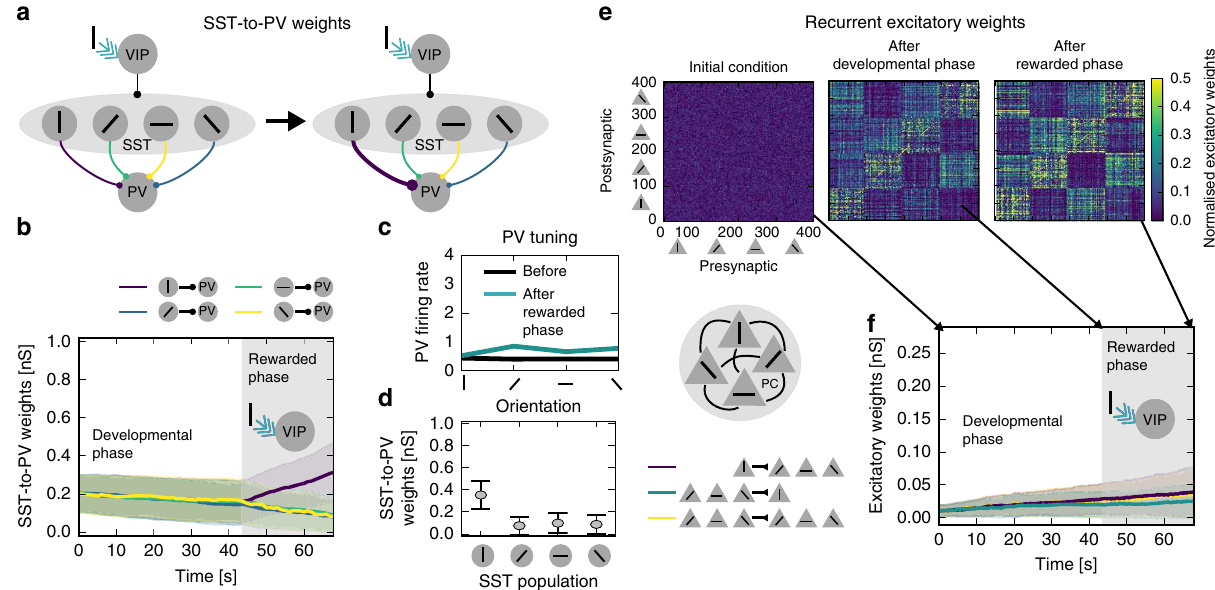
Fig. 2 Top-down reward signal triggers plasticity in the inhibitory circuit. a Illustration of changes in the inhibitory structure during top-down modulation (cyan arrow). b Evolution of the inhibitory SST-to-PV connections, grouped according to SST tuning preference (colours match the connections in a , shown are the mean and s.d.). c Tuning of PVs after the rewarded phase. d SST-to-PV weights (mean and s.d.) at the end of the rewarded phase, grouped according to SST tuning preference. e Recurrent excitatory weights at different time points in the simulation (initial random condition, after the developmental phase, after the rewarded phase). f Evolution of excitatory connections (mean and s.d.). Vertically tuned PCs to vertically tuned PCs (green), vertically tuned PCs to non-vertically tuned PCs (purple), non-vertically tuned PCs to non-vertically tuned PCs (yellow)